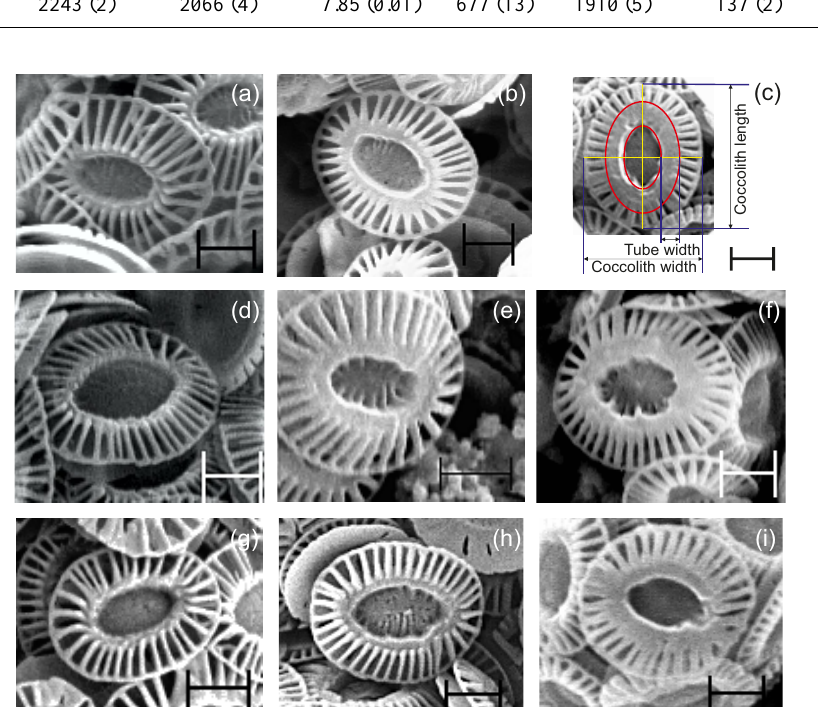
Figure 2. Examples of tube width variations observed in E. huxleyi RCC1710 (a–c) , RCC1252 (d–f) , and IAN01 (g–i) coccoliths. Tube width (c) was measured along the two semi-minor axes (along the coccolith width) of each coccolith and averaged. Scale bar equal to